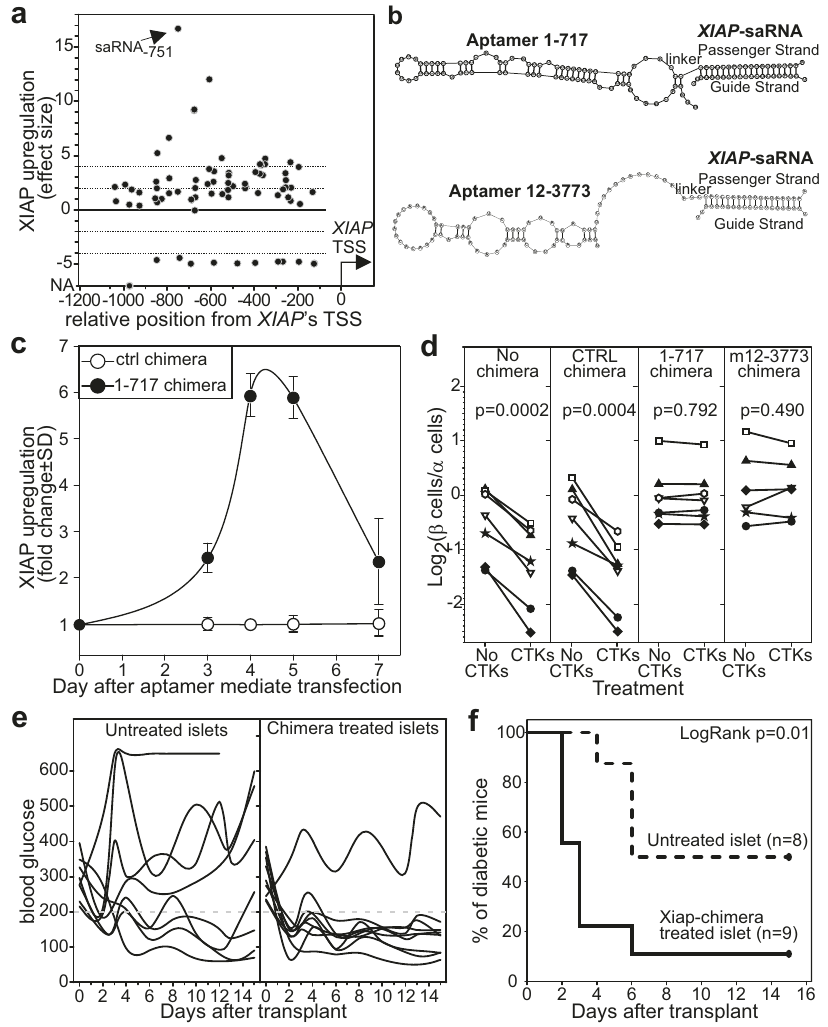
Fig. 7 Aptamer 1-717 and m12-3773 conjugated with saRNA XIAP prevent early graft loss and improve the ef fi cacy of islet transplantation. a Identi fi cation of saRNAs able to upregulate human XIAP. A549 cells were left untreated or transfected with 75 putative saRNAs identi fi ed by bioinformatic analysis on the genomic region between − 100 and − 1200 bp from the XIAP transcription starting site (TSS). Forty-eight hours later, XIAP expression was evaluated by qRT-PCR. Results are expressed as effect size [(2 − Δ CTexp − 2 − Δ CTctrl )/SD exp ] from three replicates. b Chimeras schematic representation. Chimeras were generated by extending the 3 ′ end of the aptamer with a CC link and the relevant passenger strand and subsequent annealing the desired saRNA. c saRNA -751 /1-717 chimeras or saRNA scrambled /1-717 chimeras were added to human islet culture. XIAP expression was evaluated by qRT-PCR at the indicated timepoints. Mean, and standard deviation from n = 3 biologically independent samples are shown. d Chimeras prevent cytokine-induced β cell loss. Chimeras (420 pmoles) composed of saRNA -751 and either aptamer 1-717 or m12-3773 were added to human islets (250 IEQ). Negative controls included untreated cells and cells treated with scrambled saRNA conjugated to either 1-717 or m12-3773 aptamers. Forty-eight hours after transfection, islets were challenged with TNF α , IL-1 β , and IFN γ , and the β / α cell ratio was determined by fl ow cytometry. Paired t test p values are shown. e , f Chimeras improve the ef fi cacy of islet transplantation. Human islets (500 IEQ) were treated 24 and 48h after isolation with an equimolar mixture saRNA -751 /1-717 and saRNA -751 / m12-3773 chimeras (420pmoles each) and immediately transplanted under the kidney capsule of diabetic NOG mice. Untreated islets from the same preparation were used as control. Blood glycemia was monitored three times a week. Data are derived from two independent experiments. e Blood glucose concentration of the individual mouse. f Kaplan – Meyer curve and log-rank survival analysis. Source data are provided as a Source Data fi